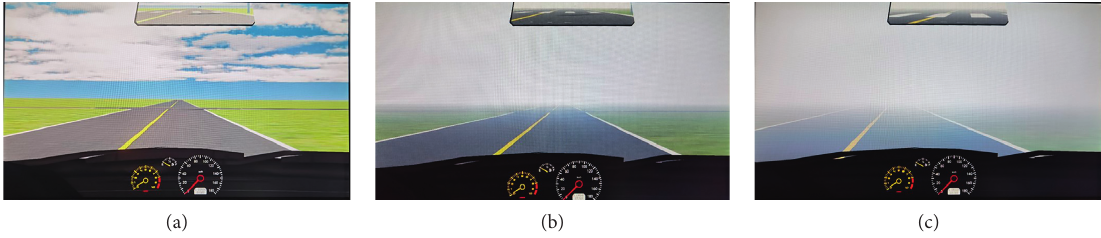
Figure 3: Driving interface in different fog conditions. (a) No fog. (b) Light fog. (c) Heavy fog.